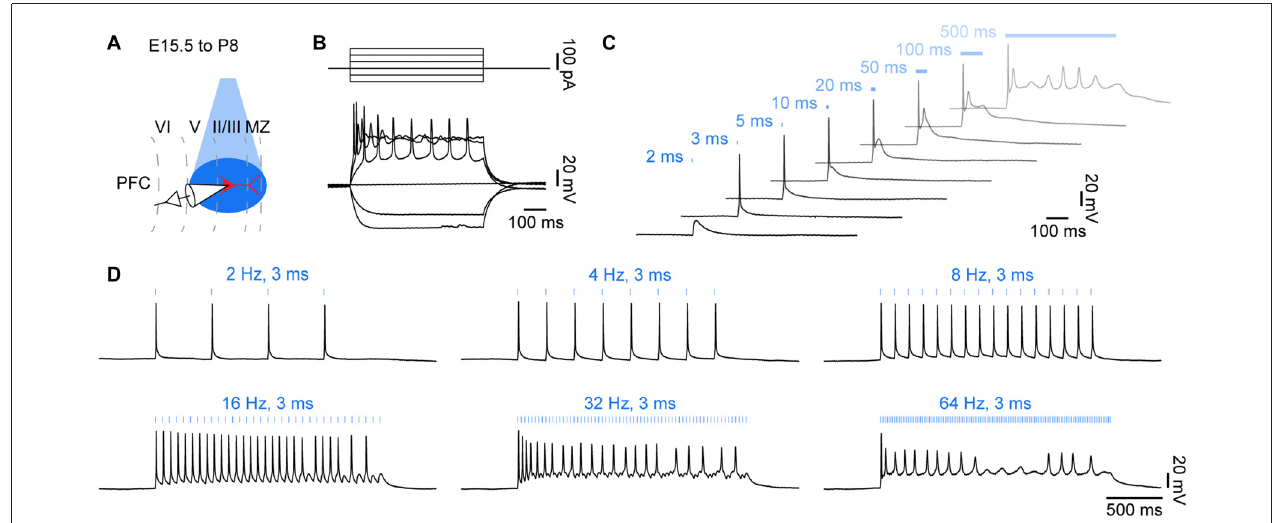
FIGURE 2 | Optogenetic control of action potential firing in neonatal brain slices in vitro . (A) Diagram illustrating combined light stimulation and whole-cell patch-clamp recordings from layer II/III pyramidal neurons in coronal slices of P8–10 mice transfected with channelrhodopsin 2 double mutant E123T T159C (ChR2(ET/TC)) by IUE at E15.5. (B) Voltage responses of a ChR2(ET/TC)-transfected neuron to hyper- and depolarizing current pulses. (C) Voltage responses of a ChR2(ET/TC)-transfected neuron to blue light pulses (473 nm, 5.2 mW/mm 2 ) of 2–500 ms duration. (D) Voltage responses of a ChR2(ET/TC)-transfected neuron to repetitive trains of 3 ms-long light pulses at different